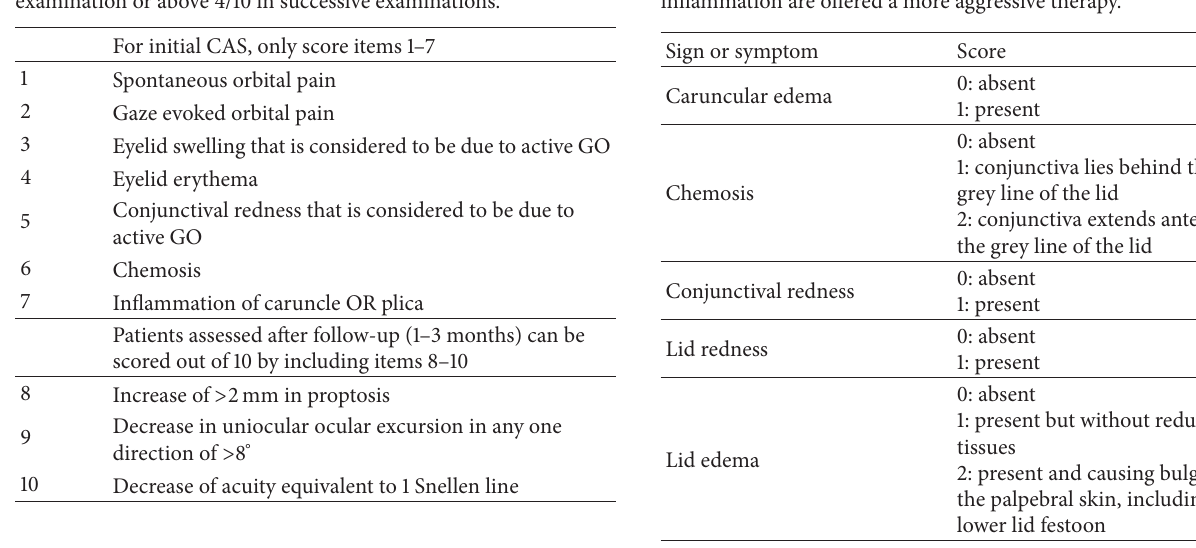
Table 2: Clinical Activity Score (CAS) (amended by EUGOGO after Mourits et al.). One point is given for the presence of each of the parameters assessed. The sum of all points defines clinical activity: active ophthalmopathy if the score is above 3/7 at the first examination or above 4/10 in successive examinations.